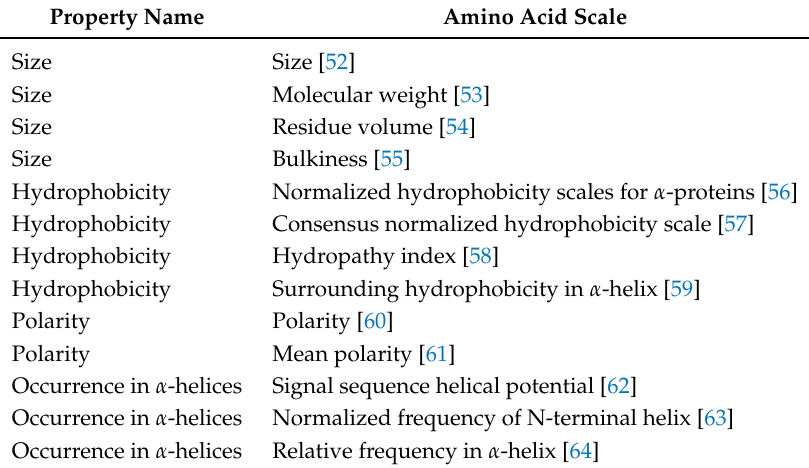
Table 5. Properties of amino acids used in their